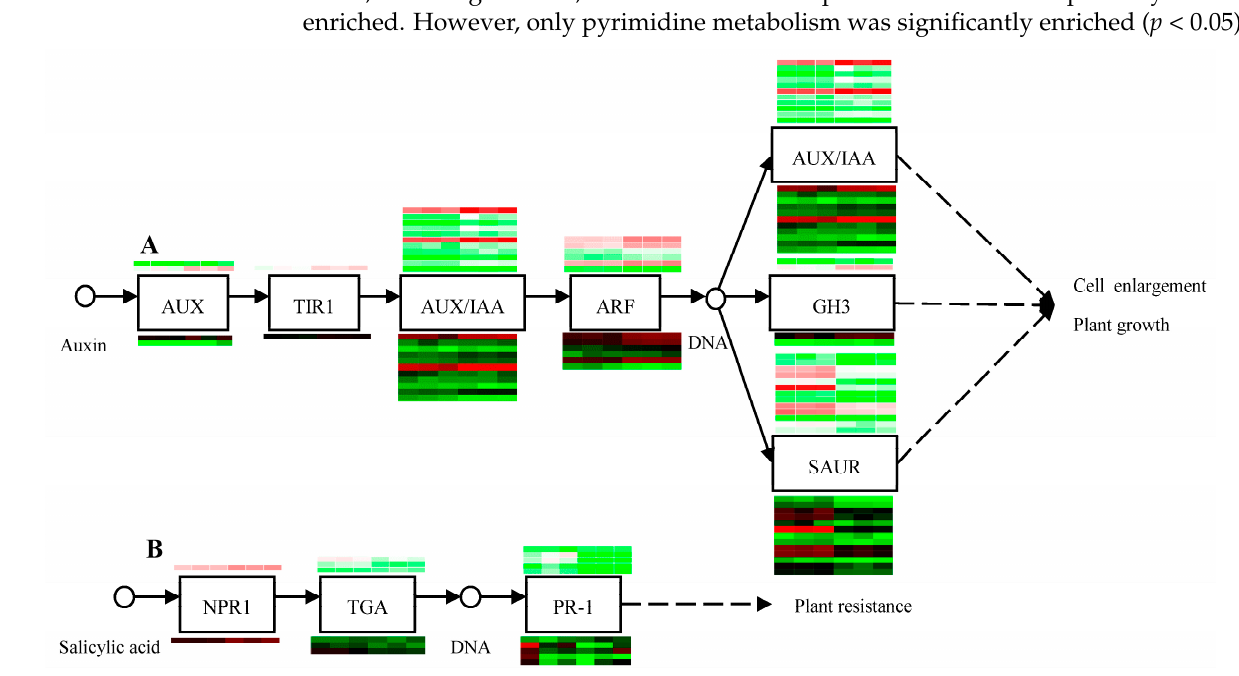
Figure 5. Regulatory network for DEGs involved in auxin and salicylic acid signal transduction. ( A ) Auxin signal transduction. ( B ) Salicylic acid signal transduction. The heat maps above and below the boxed genes are for the LTS responsive DEGs in QL and RA, respectively. The first three columns are for the three replicates of samples under normal conditions, and the later three columns are for the LTS treated three replicates. Colors represent the relative expression levels of the genes, and the redder the color, the higher the gene expression, and the greener the color, the lower the expression. Table 7. KEGG enrichment analysis of predicted DEM target genes in the comparison of QLCK vs.